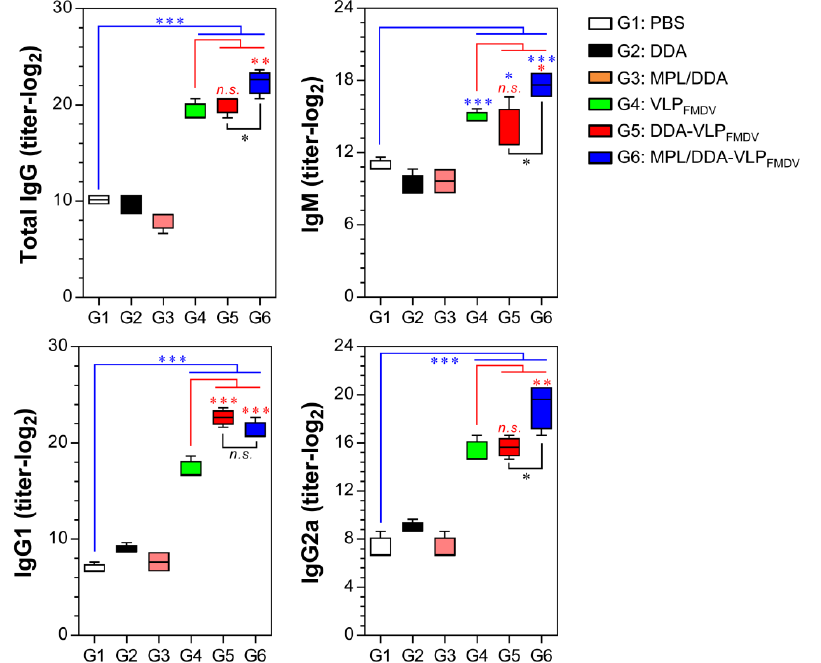
Figure 5. Analysis of VLP-specific serum antibody isotype. Mice were immunized twice with VLP FMDV in different adjuvant combinations. Two weeks after final immunization, serum from five mice in each group was obtained, and the VLP-specific IgG, IgM, IgG1 and IgG2a were analyzed using ELISA. Data from one of two independent experiments are shown. * p < 0.05, ** p < 0.01, *** p < 0.001. n.s.: not significant.